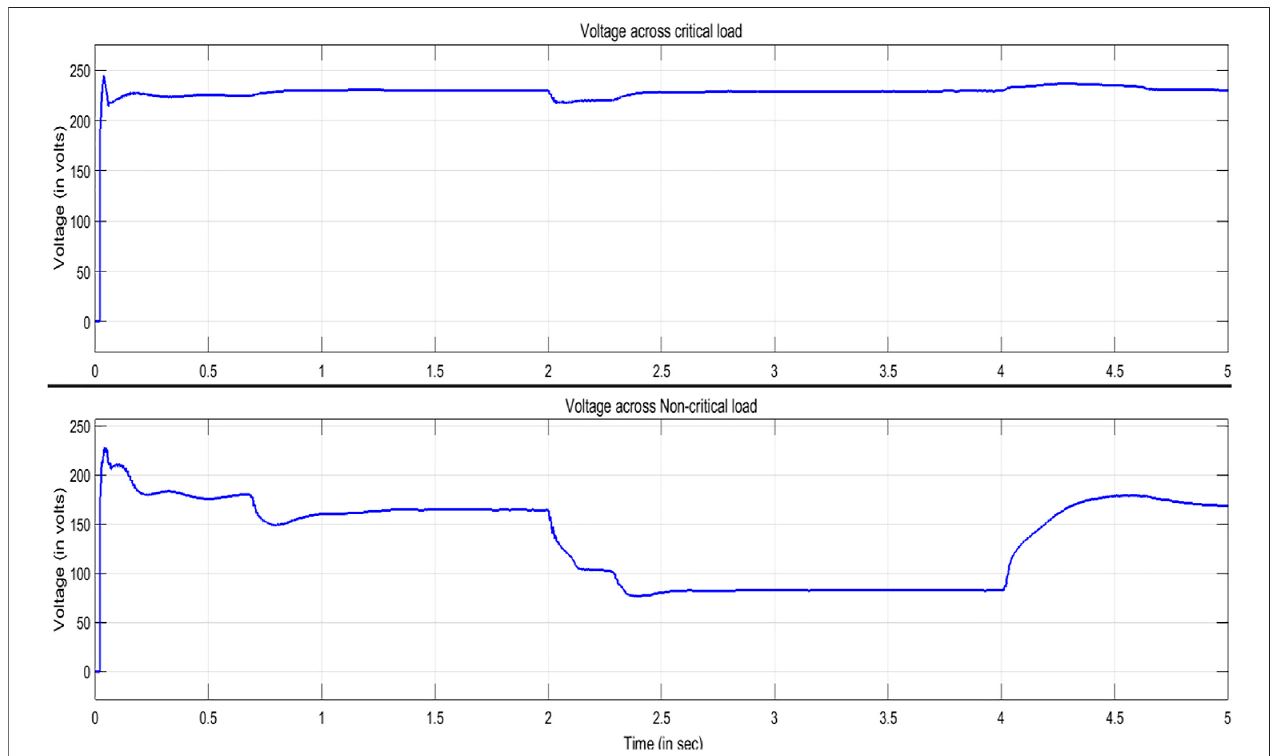
FIGURE 13 | Voltage across critical and non-critical